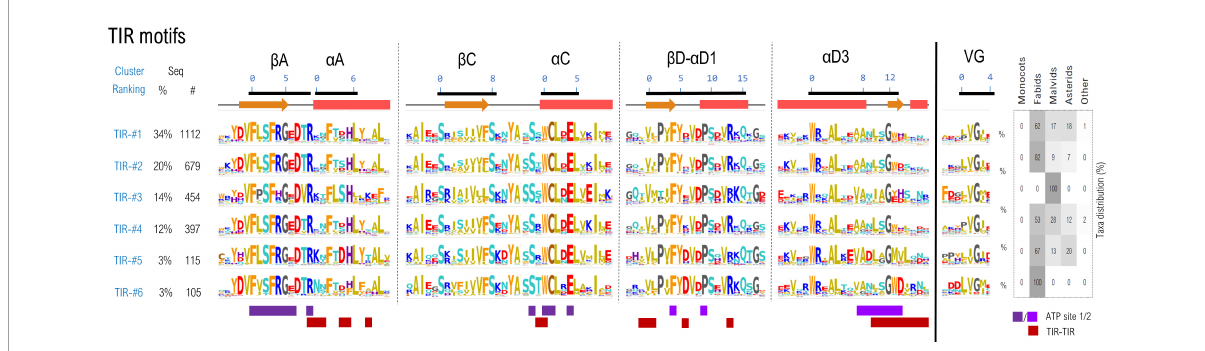
FIGURE3 Sequence clustering of the TIR domains based on the confined motif regions. Motif variability is expressed as relative entropy displayed as letter height, while the taxonomic distributions of each cluster is depicted in the right panel. The ATP contacts within 5Å are mapped below the motif consensus (light/dark purple—ATP binding sites 1 and 2 PDB: 7crc). Amino acids are colored according to their properties as follows: yellow, hydrophobic; orange, aromatic; brown, cysteine; cyan, polar; red, acidic; blue, basic; gray, proline, and glycine.